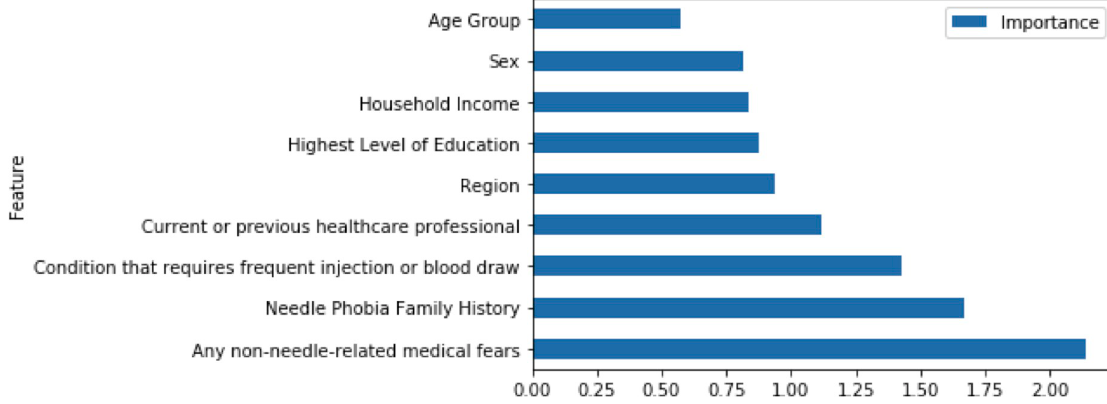
the intensity of needle fear experienced by the subjects. Participants with needle phobia